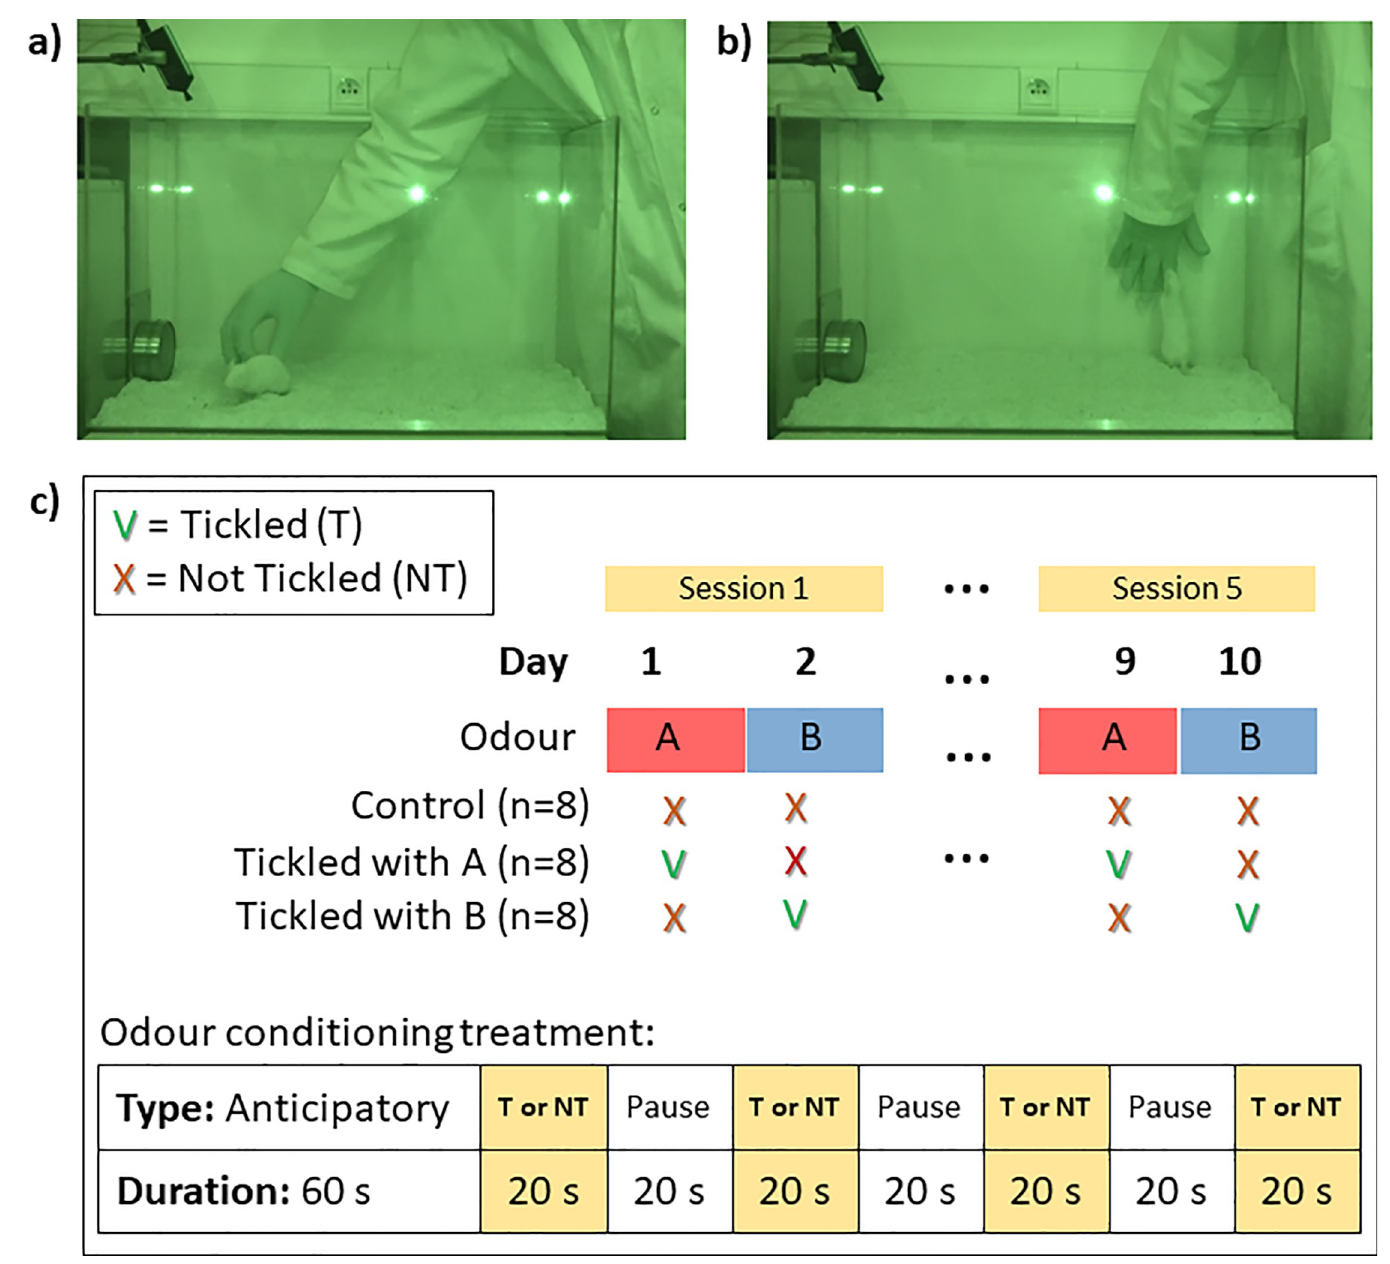
Fig 1. Odour conditioning schedule. Screen-shots from the video recording of an odour conditioning session, showing a) the rat being tickled, and b) the position of the hand flat against the arena wall during the pauses between tickling periods. The container with the odour source can be seen in the left of the pictures. The pictures have a green hue as the procedure was carried out under red lighting; c) Diagram of the odour conditioning schedule over days and within treatment, with only the 1 st (days 1 and 2) and 5 th (days 9 and 10) session shown. Control rats were never tickled and A-tickled rats were tickled when odour A was present in the container, and B-tickled rats were tickled when odour B was present in the container in the test arena. When odour A was in the container, the B-tickled rats were treated as the Control rats, as was the A-tickled rats when odour B was in the container.